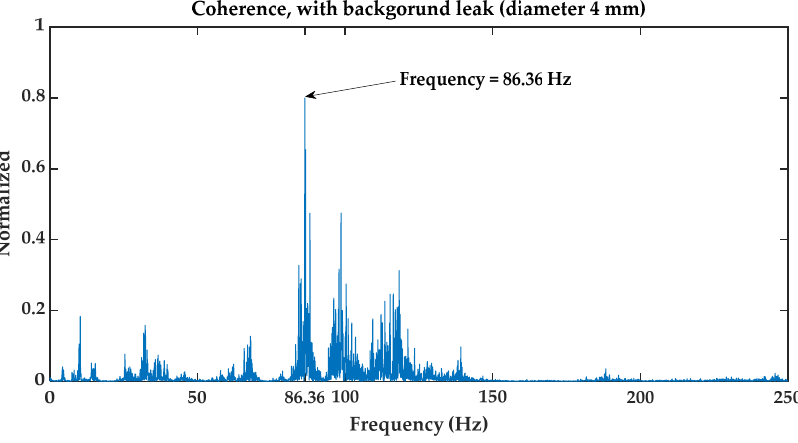
Figure 18. Coherence, with background leak ( 4 mm in diameter) and flow rate 125.0 mL/s .